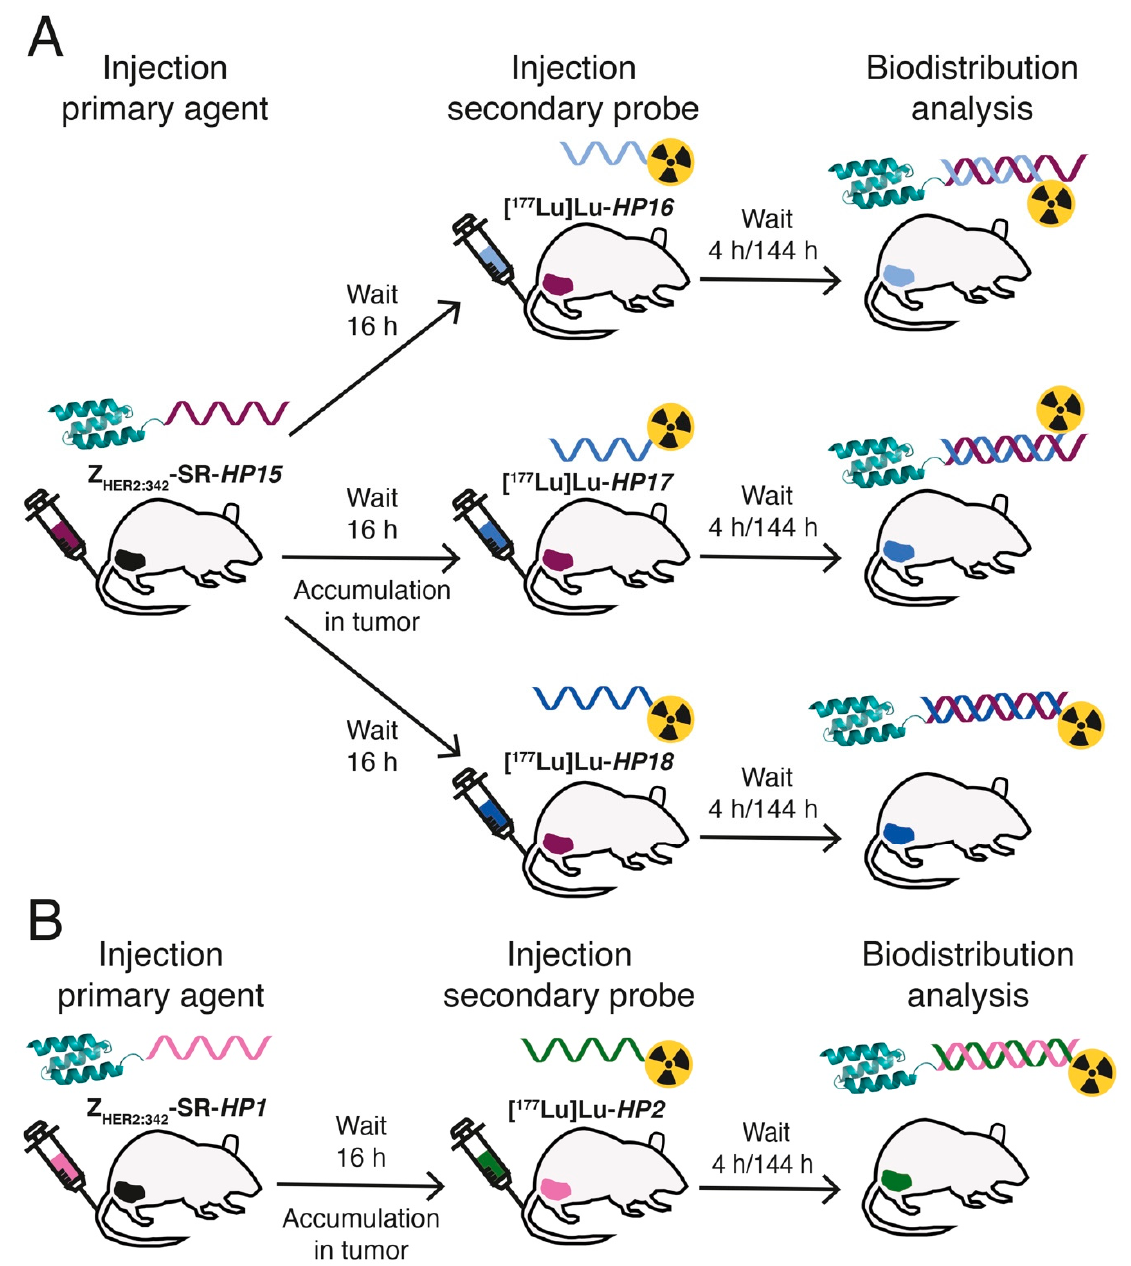
Figure 2. Schematic representation of the pretargeting protocol used for in vivo biodistribution analysis of the new 177 Lu- labeled secondary probes. ( A ) Thirty mice carrying HER2-overexpressing SKOV3 xenografts in their right hind legs received an injection of Z HER2:342 -SR- HP15 in the tail vein. The mice were randomly split into three groups of ten mice, and, after a 16 h waiting period, all mice received a second injection of a 177 Lu-labeled secondary probe—[ 177 Lu]Lu- HP16 , [ 177 Lu]Lu- HP17, or [ 177 Lu]Lu- HP18 . All mice were euthanized for biodistribution analysis at 4 h/144 h after injection of the secondary probe. The uptake of radioactivity, expressed as a percentage of the total injected dose per gram of sample (% ID/g) in the organs of interest and the tumor, was then calculated as the average value from five mice. ( B ) As a biodistribution comparison, the uptake of the previously studied first-generation secondary probe, [ 177 Lu]Lu- HP2 , was measured using the same protocol for the new secondary probes described above but with Z HER2:342 -SR- HP1 as the primary agent in the first injection.